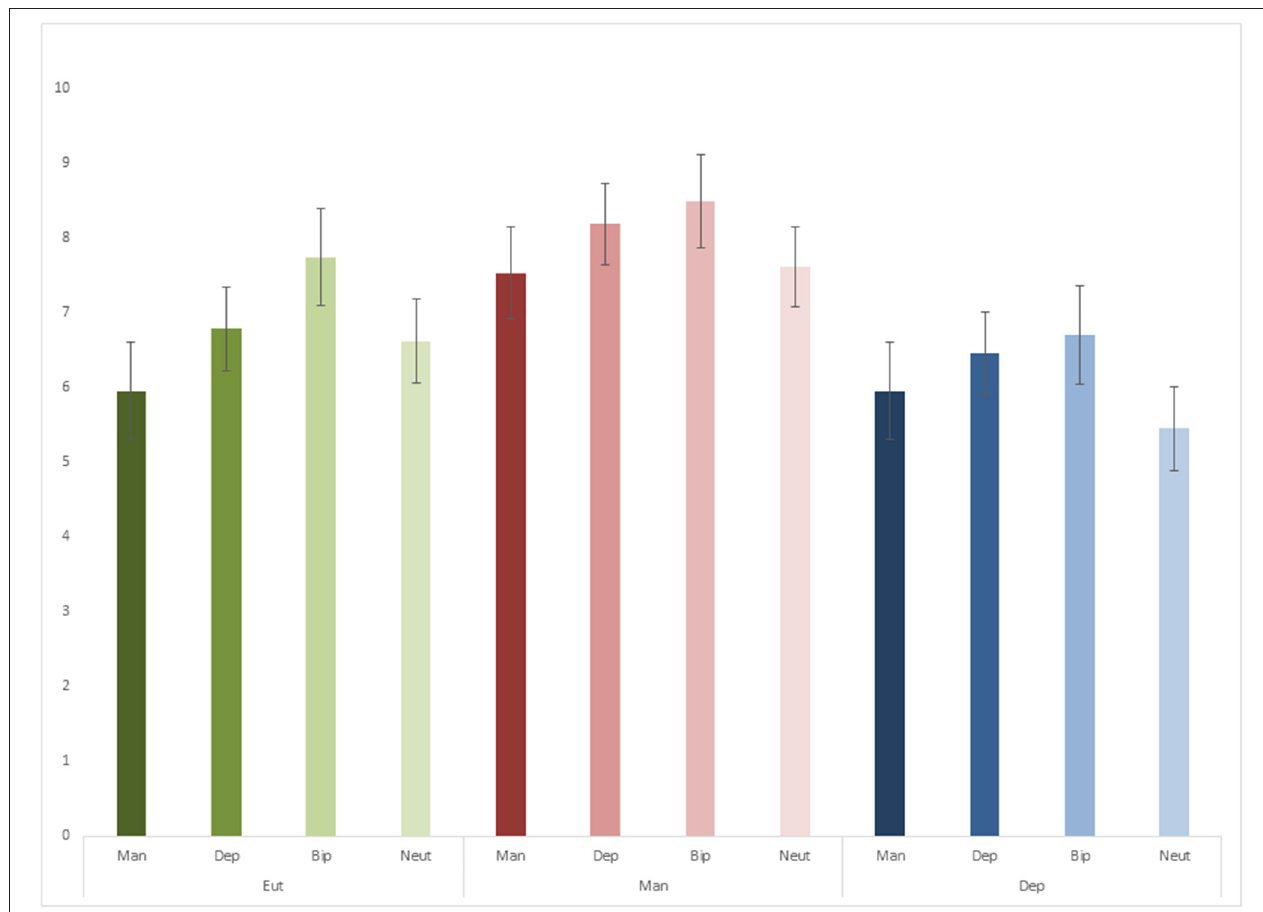
FIGURE 2 | Episodic re-experiencing